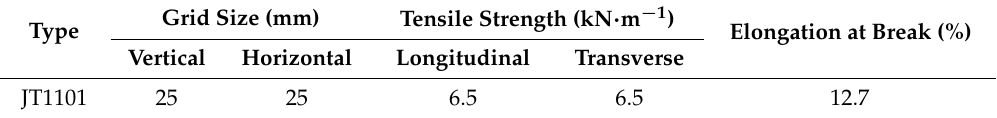
Table 1. Basic property of geo-grid.